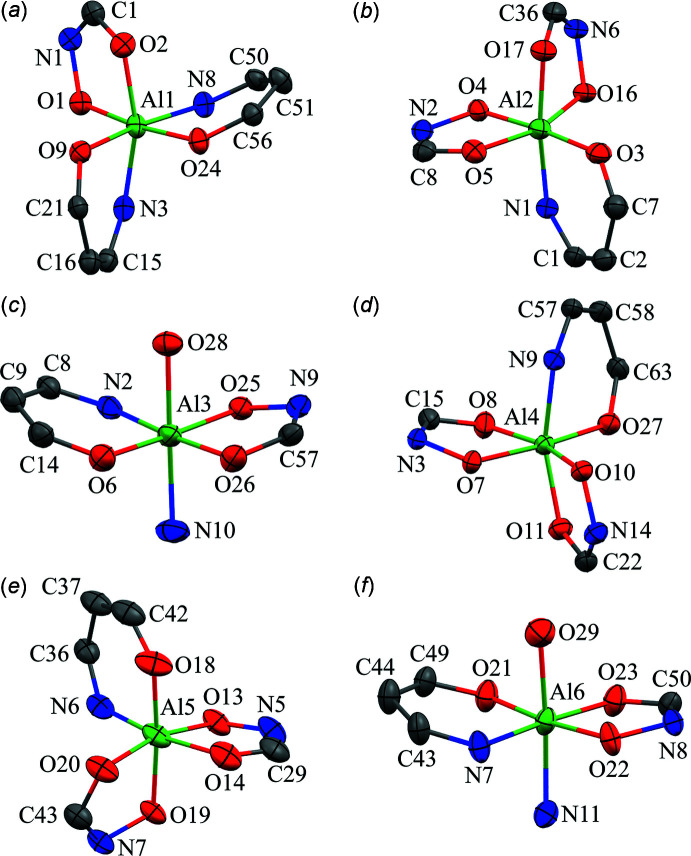
Coordination geometries for the AlIII ions of 1: (a) Al1 – octa­hedral, Λ; (b) Al2 – octa­hedral, Δ; (c) Al3 – octa­hedral; (d) Al4 – octa­hedral, Δ; (e) Al5 – octa­hedral, Λ; (f) Al6 – octa­hedral. See Fig. 1 ▸ for additional display details.